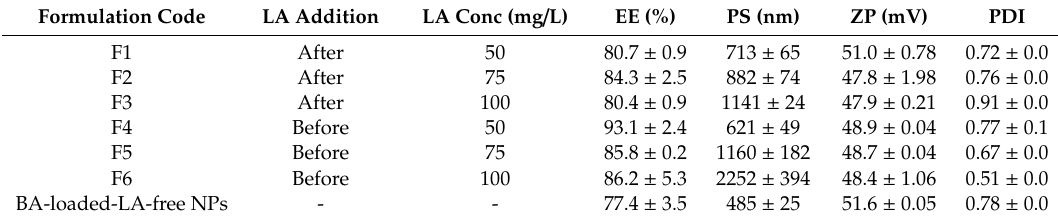
Table 1. The e ff ect of process and formulation variables on the entrapment e ffi ciency (EE%), particle size (PS), zeta potential (ZP) and polydispersity (PDI) of